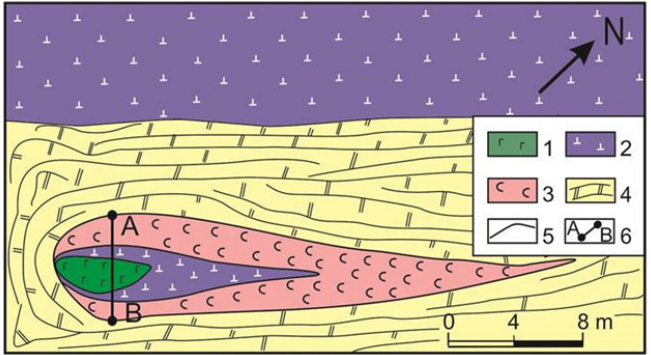
Figure 6. Geological sketch of a pyroxenite fragment with remnant dolerite in the middle. 1 = dolerite; 2 = pyroxenite; 3 = skarned pyroxenite; 4 = marble; 5 = geological boundaries; 6 = sampled profile from SE1250c1 (A) to SE1250c20 (B).